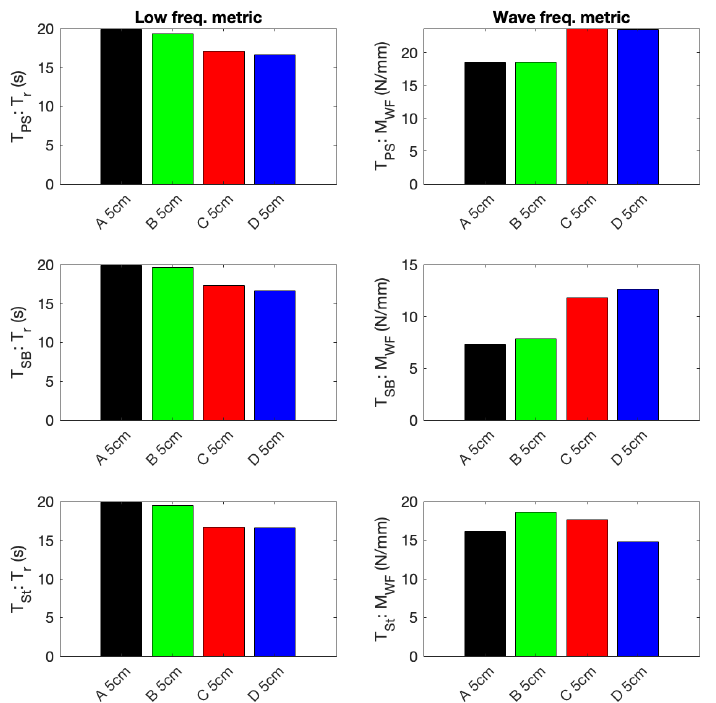
Figure 9. Metric T r (left column) and M WF (right column) for JONSWAP T p = 1.29, H s = 5cm for all facilities given for the tensions in port mooring line ( T PS ; top row), starboard mooring line ( T SB ; middle row) and stern mooring line ( T St ; bottom